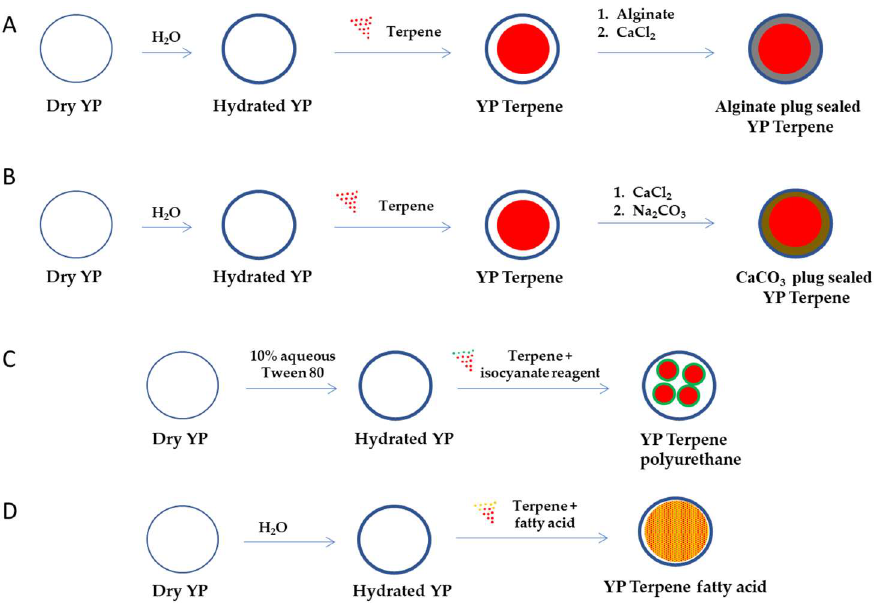
Figure 2. Schematic representation of steps required to encapsulate terpenes in YPs using ( A ) an alginate plug seal, ( B ) calcium carbonate plug seal, ( C ) encapsulation of terpenes in polyurethane nanoparticles, and ( D ) co-encapsulation with fatty acids (YP–terpene fatty acid can also be prepared by sequential loading of fatty acid and then the terpene) .